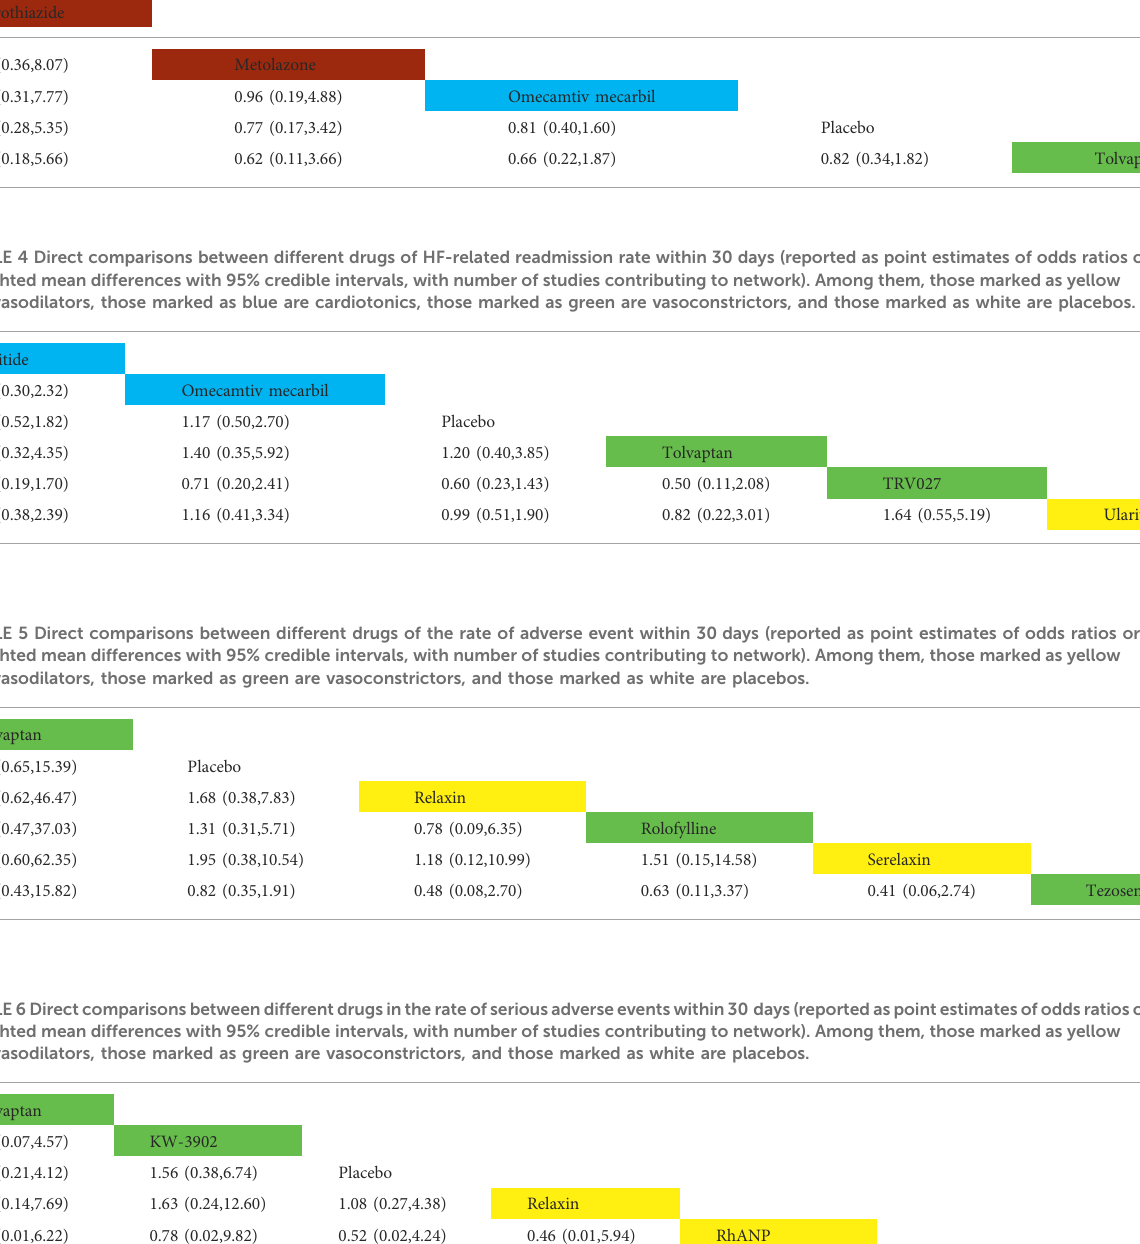
TABLE 3 Direct comparisons between different drugs of all-cause readmission rate within 30 days (reported as point estimates of odds ratios or weighted mean differences with 95% credible intervals, with number of studies contributing to network). Among them, those marked as red are diuretics, those marked as blue are cardiotonics, those marked as green are vasoconstrictors, and those marked as white are placebos. Chlorothiazide